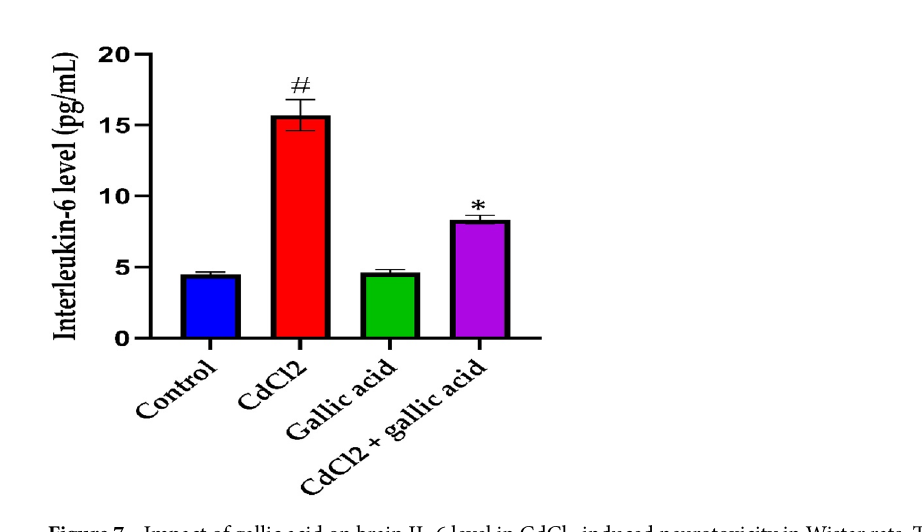
Figure 7. Impact of gallic acid on brain IL-6 level in CdCl 2 -induced neurotoxicity in Wistar rats. The data is represented as mean ± SD (n = 5). # Significant at p < 0.05 compared to the control; *Significant at p < 0.05 compared to CdCl 2 alone